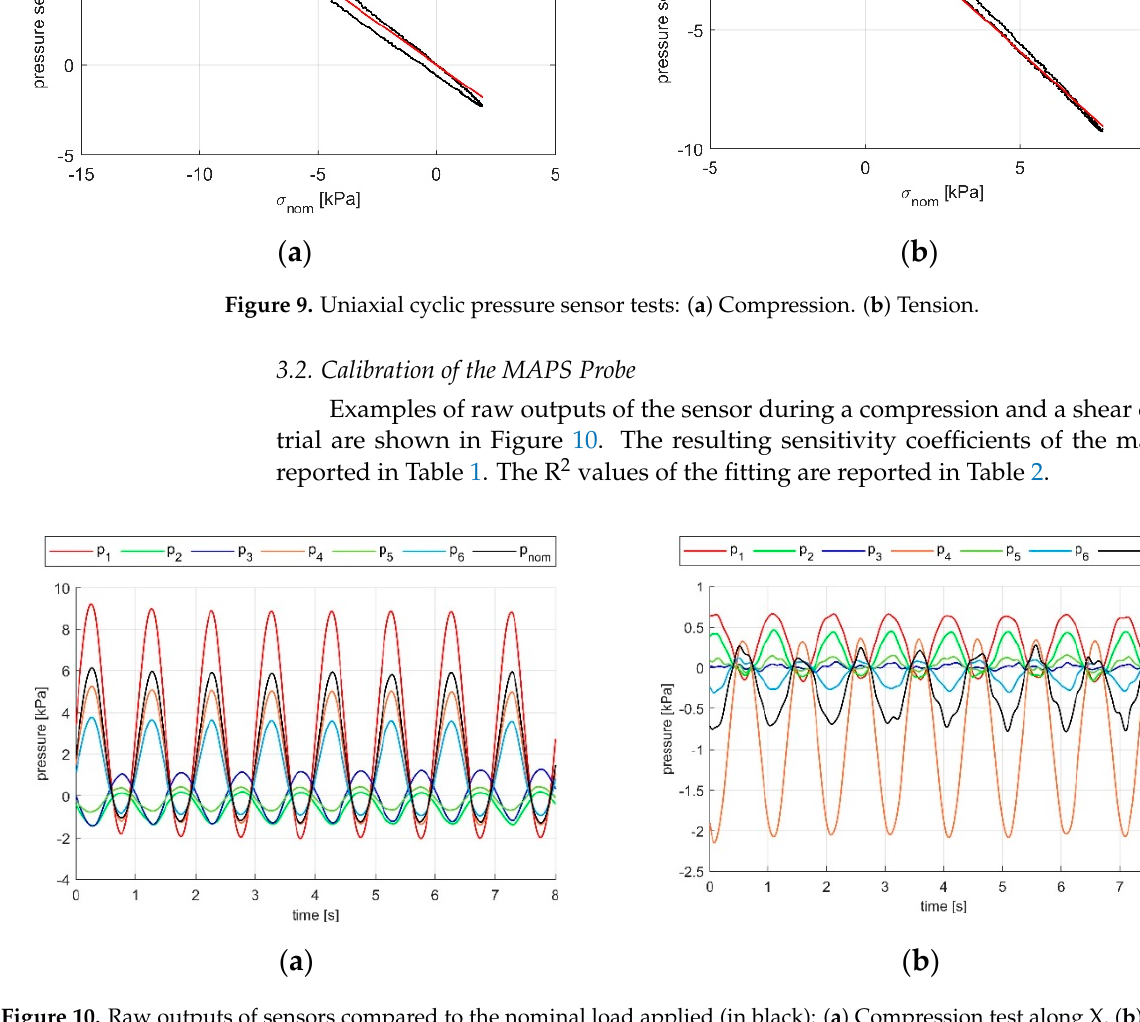
− 2.798 Table 2. R 2 index of the sensitivity matrix coefficients of Table 1. Sensor ID Orientation